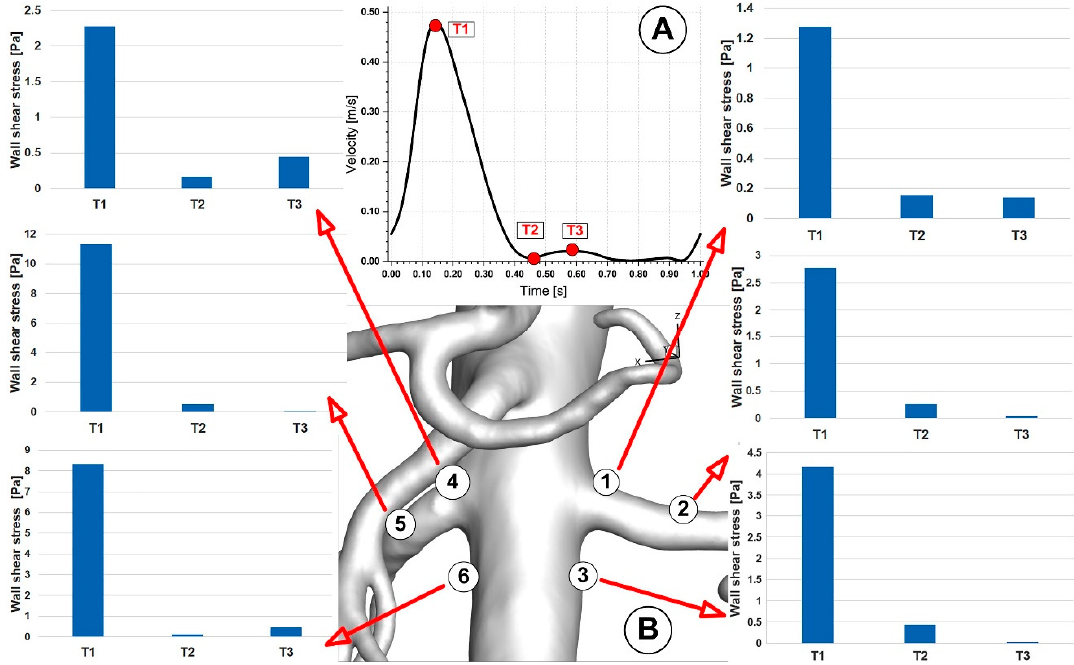
Figure 16. WSS evolution at various locations along the renal arteries ( B ) during different time steps (corresponding to time T1, T2, and T3, respectively ( A )).